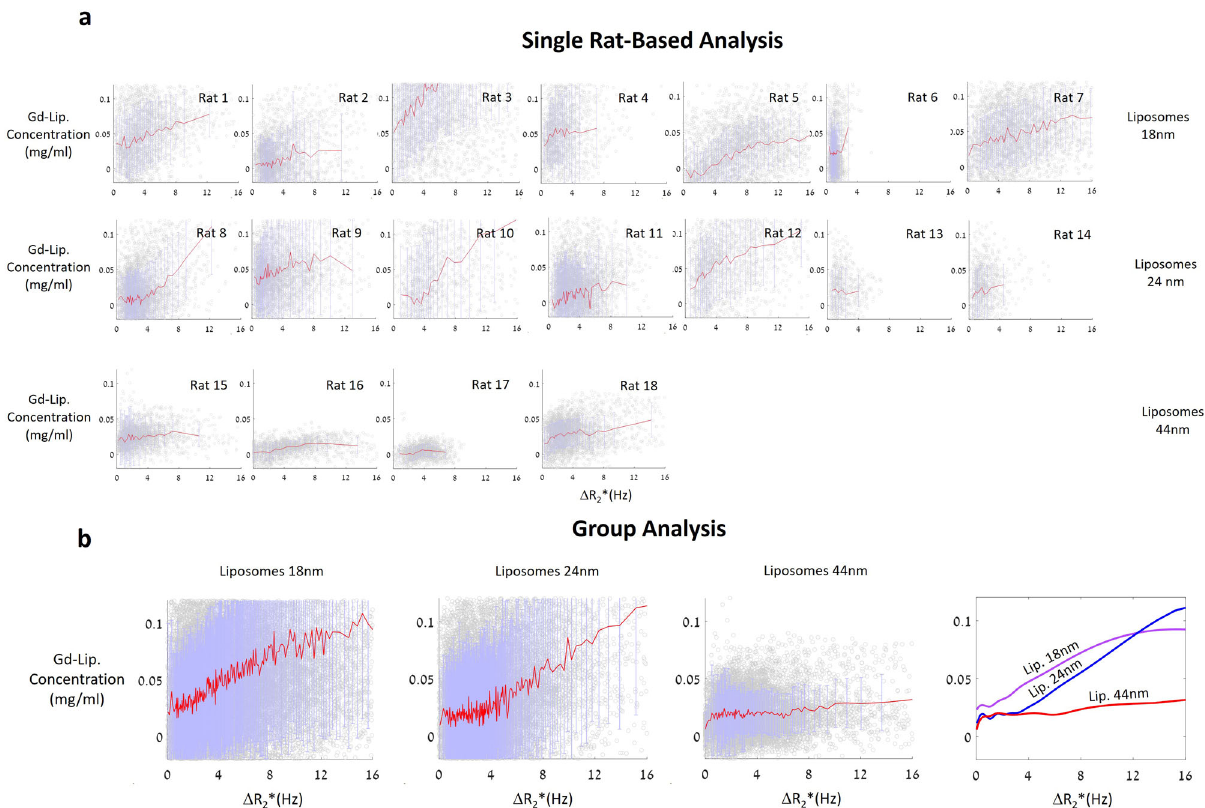
Fig. 5 Relation between Δ R 2 * and Gd-liposome concentrations. a Voxel-wise single rat-based analysis for different Gd-liposome populations. Gray circles are the voxel-wise data points, red curves are the means of every 100 adjacent points in the fi gures, and purple bars are the standard deviations. Inter-rat differences are noticeable. b Same analysis as in a , but with pooled data from all rats in the same Gd-liposome population. The right-most fi gure contains interpolation curves of the curves in the left panels. Each population has other characteristics: the smaller the liposome, the higher its parenchymal concentration for the same Δ R 2 * values. In addition, the larger the liposome, the higher its Δ R 2 * threshold dependence. One-way ANOVA revealed a statistically signi fi cant difference between the liposome population parenchymal concentrations within 2-Hz Δ R 2 * bins. In addition, the analysis revealed a signi fi cant difference between the liposome threshold levels, and the signi fi cant dependence of the parenchymal concentration on Δ R 2 *. Error bars are